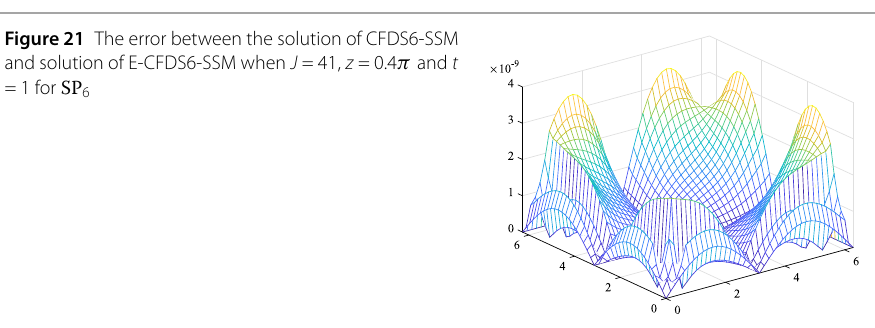
Figure 21 The error between the solution of CFDS6-SSM and solution of E-CFDS6-SSM when J = 41, z = 0.4 π and t = 1 for SP